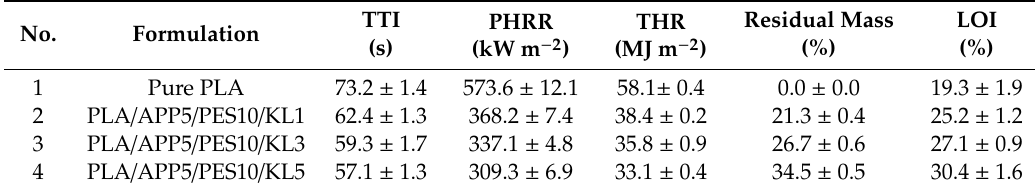
Table 8. Cone calorimetry data for pure PLA and FR PLA nonwoven fabric samples.